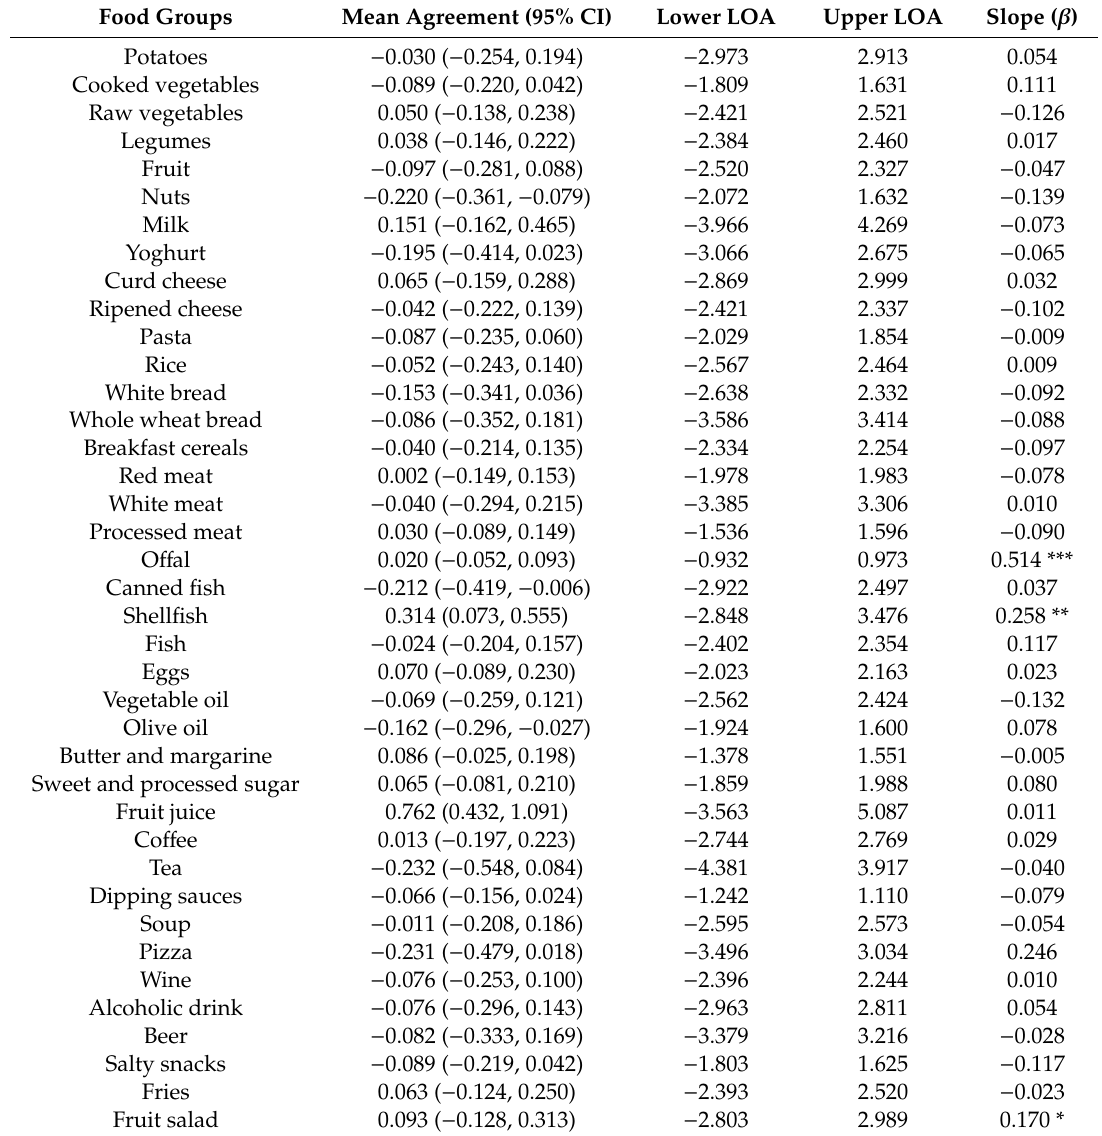
Table 3. Mean agreement and limits of agreement between food intakes estimated by the web-FFQ and the